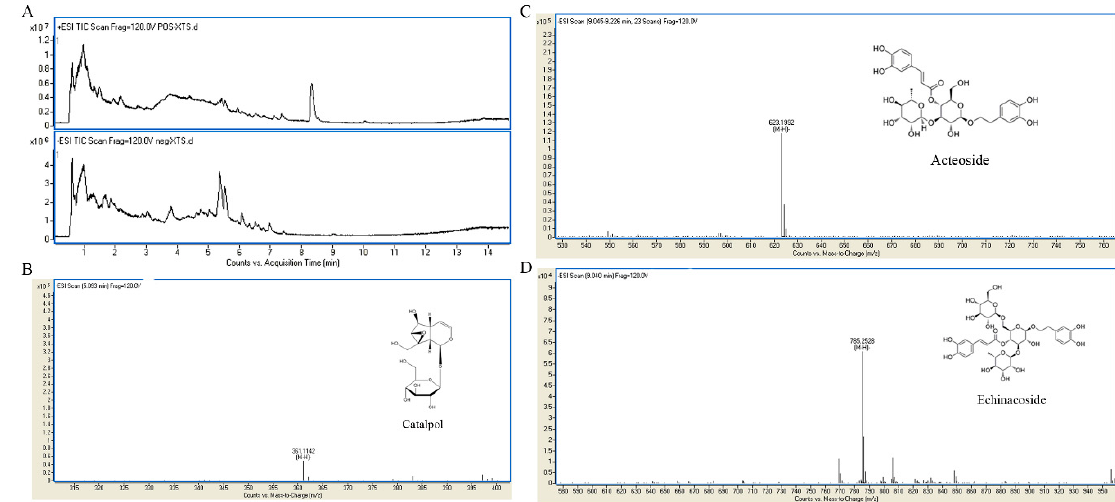
Figure 1. UHPLC-MS characteristics of RR extract. ( A ) The representative total ion chromatograms (TICs) in positive and negative ion mode; ( B ) catalpol in the RR extract sample; ( C ) acteoside in the RR extract sample; ( D ) echinacoside in the RR extract sample.